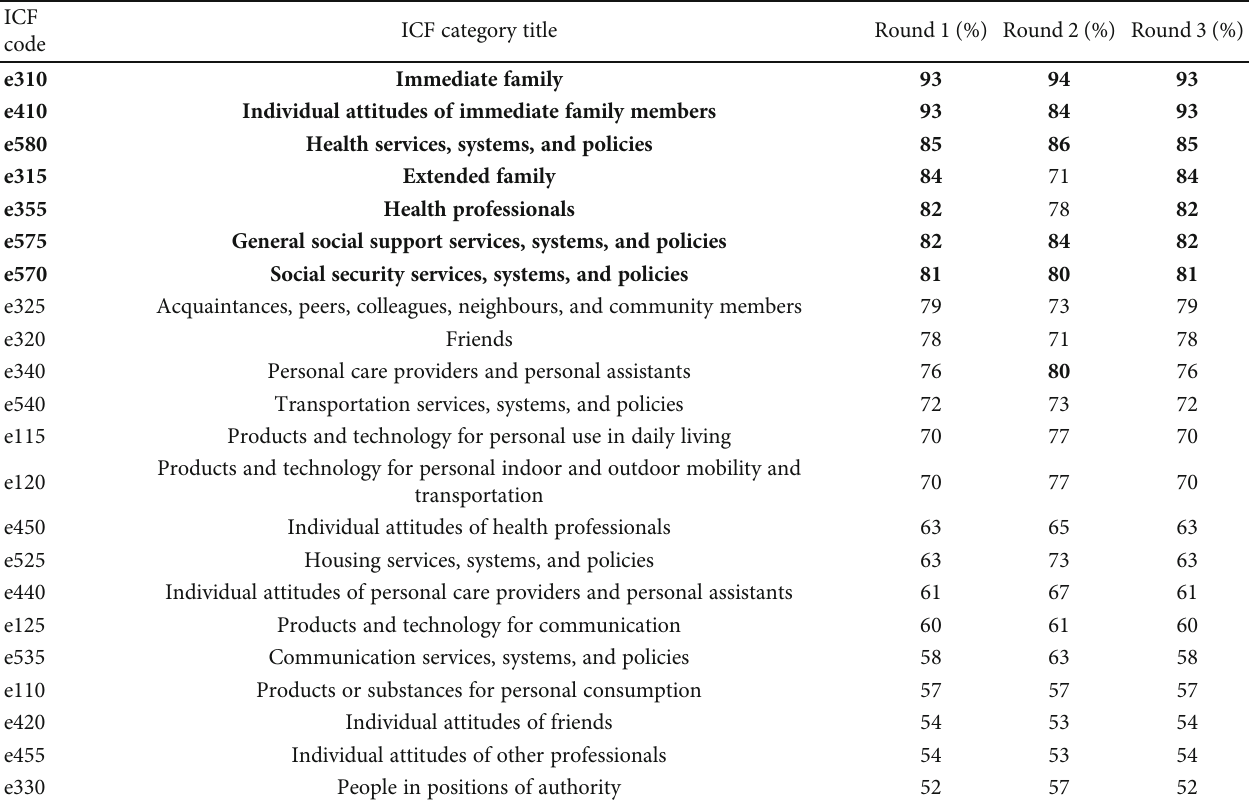
Table 6: International Classi fi cation of Functioning, Disability, and Health (ICF) environmental factor categories that were considered relevant by ≥ 50% of participants in the third round (items in bold with ≥ 80%